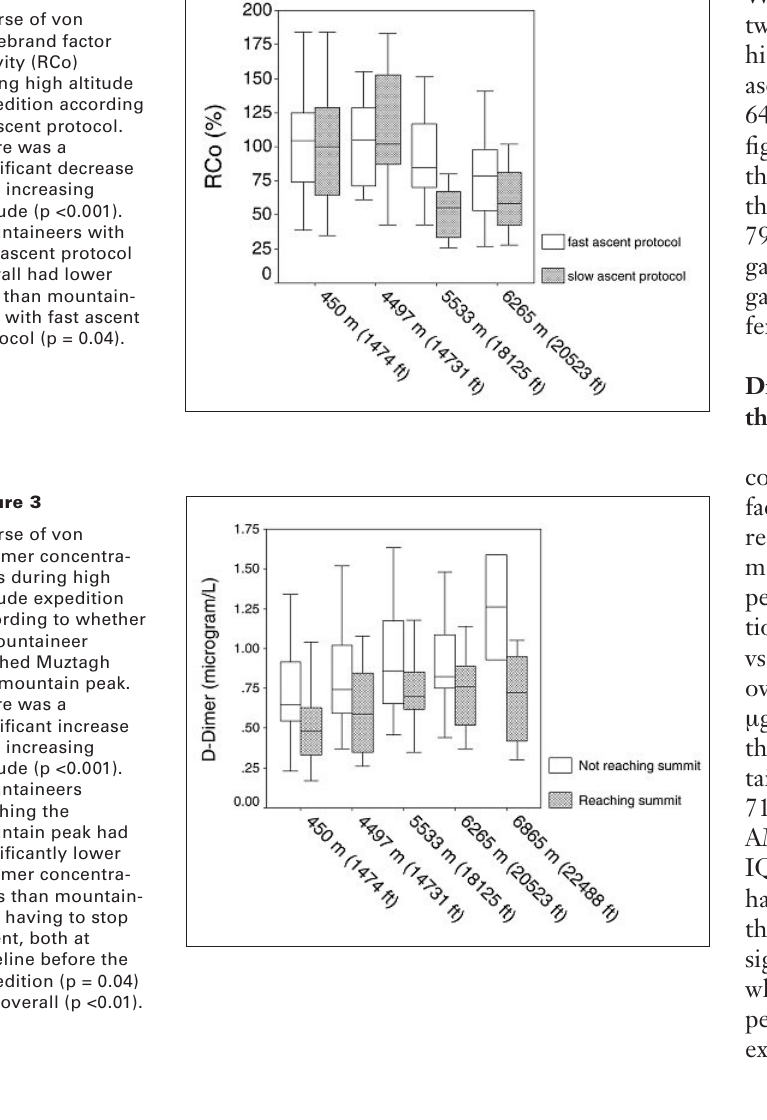
Lake Louise AMS score, oxygen saturation (SaO 2 ) and haematocrit during